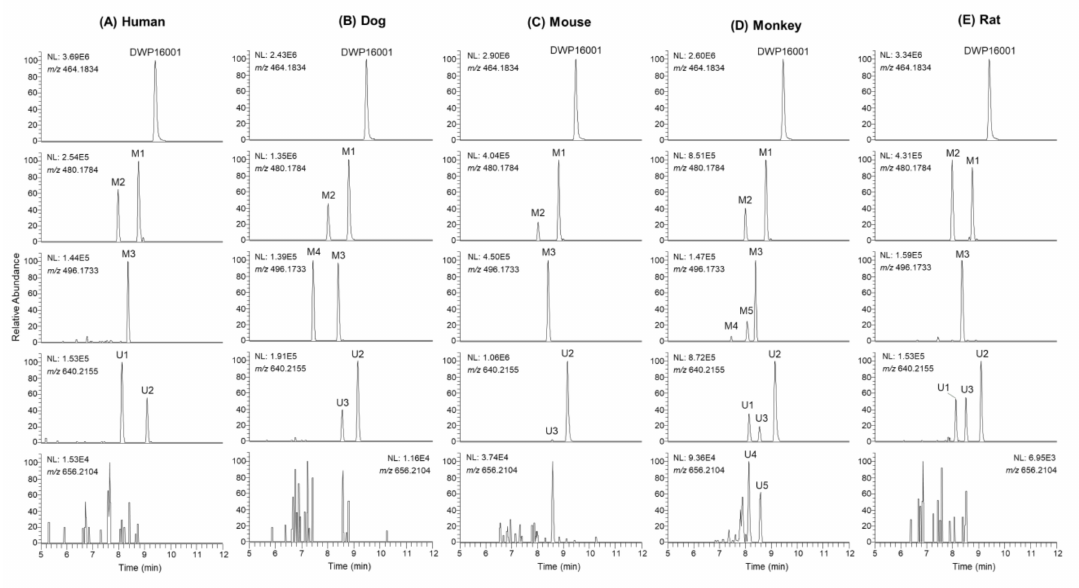
Figure 2. Extracted ion chromatograms of DWP16001 and its possible metabolites after incubation of 10 µ M DWP16001 with ( A ) human, ( B ) dog, ( C ) mouse, ( D ) monkey, and ( E ) rat hepatocytes at 37 ◦ C for 2